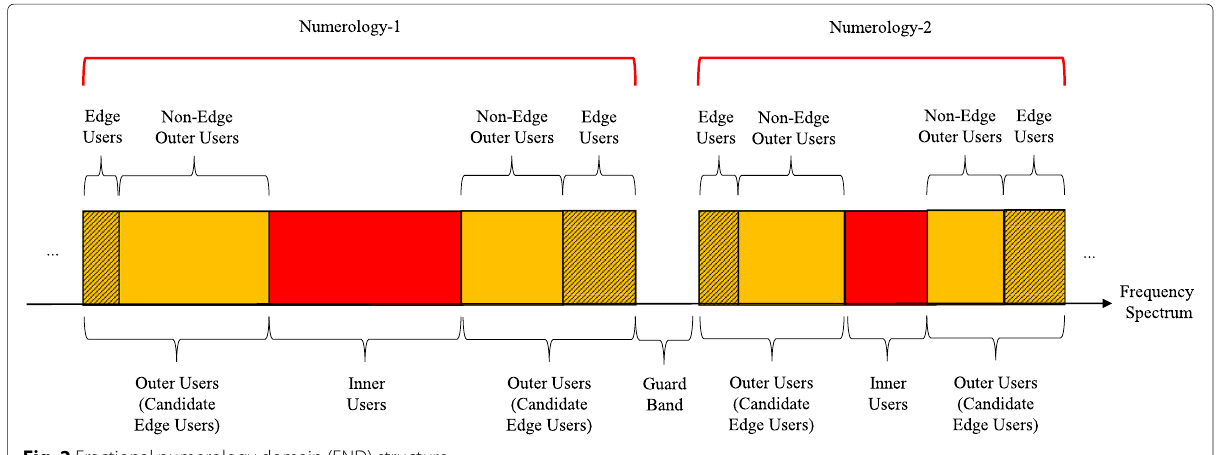
Fig. 2 Fractional numerology domain (FND)